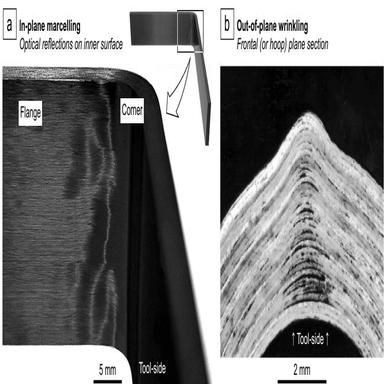
Examples of the two main fibre waviness regimes observed in UD corner laminates: (a) in-plane fibre marcelling (CFRP, hand-layup, VBO cure) ; (b) outof-plane wrinkling (CFRP, hand-layup, autoclave cure).